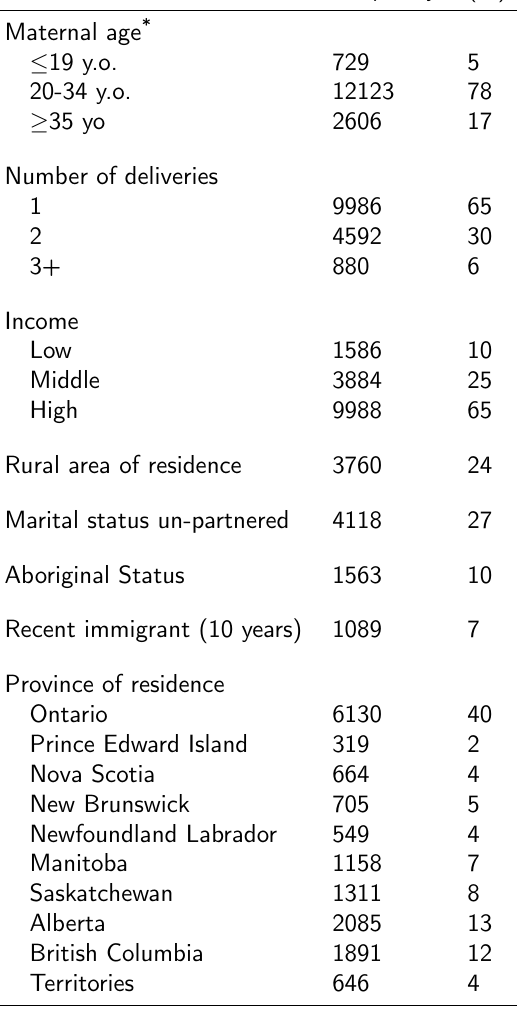
Table 1: Maternal Characteristics (n =